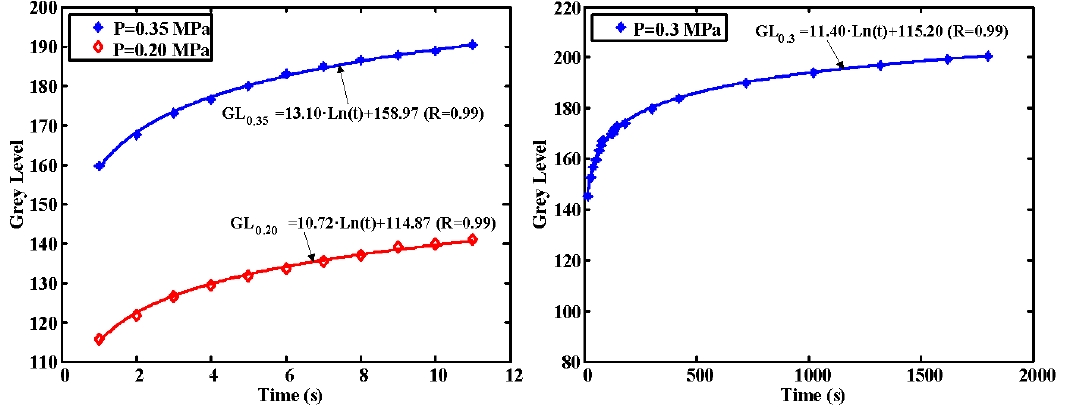
Figure 9. Grey level vs. time (creep). Short-time pressure exposition ( left ) and long-time pressure exposition ( right ).